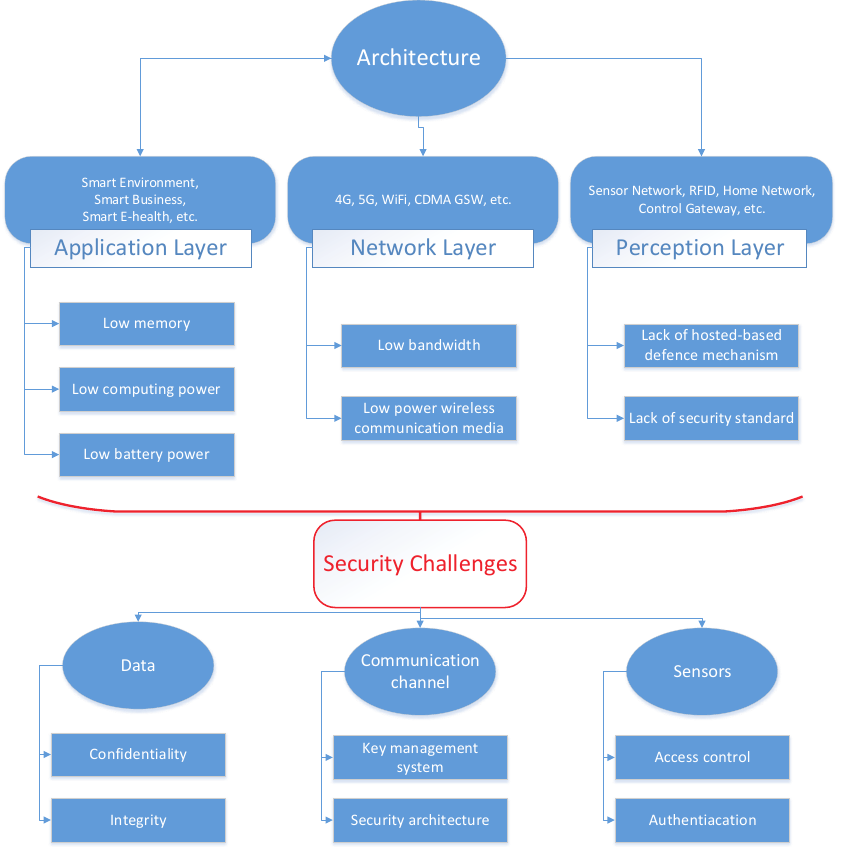
Figure 1. Architecture, bottleneck, and challenge in IoTs. Table 1. The architecture of the Internet of Things. Layer Characteristic